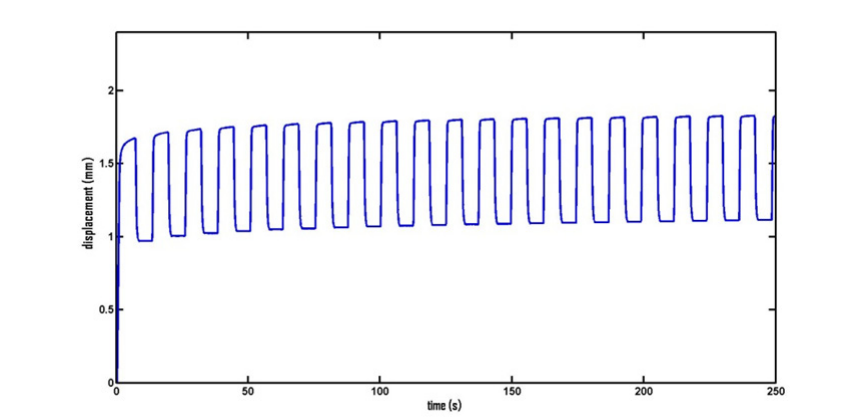
Fig. 9 Initial cycles of test at 40 ⁰ C with a hold time of